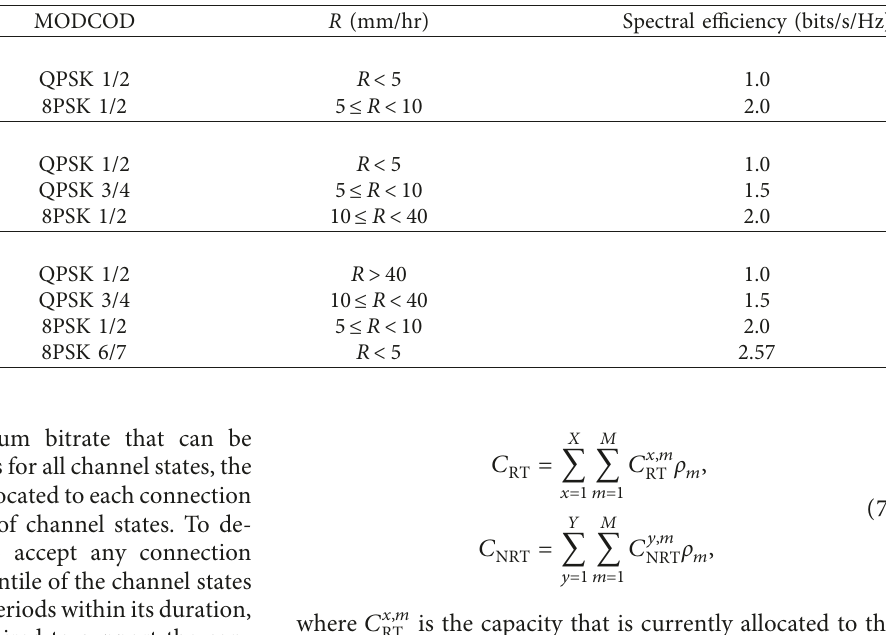
Figure 3: Rain attenuation prediction model. Table 3: AMC